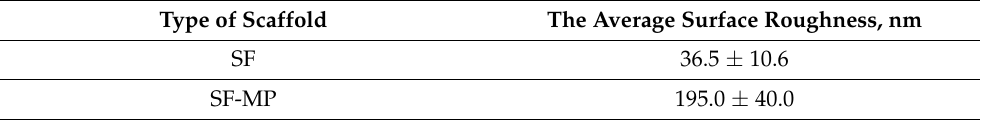
Table 1. Data on the average surface roughness of the obtained scaffolds. Standard deviation values for six independent measurements are shown.